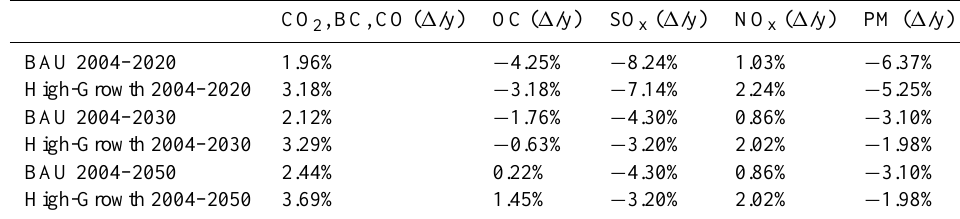
Table 6. Regional growth rates resulting from vessel-specific growth rates.